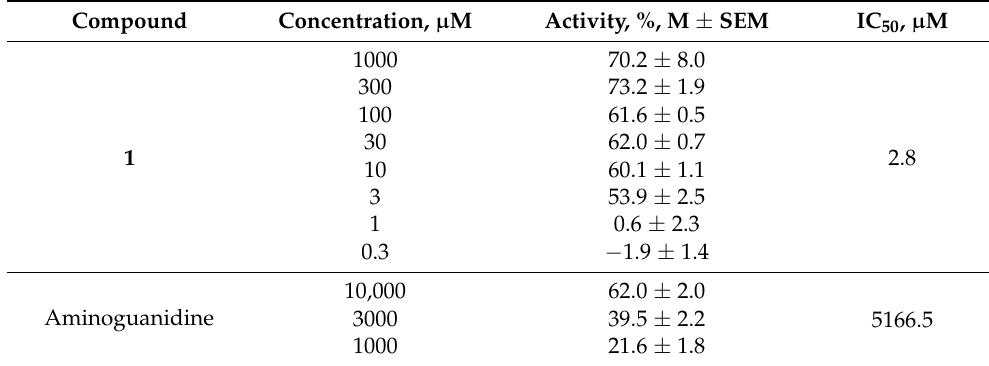
Table 2. Values established during the study of antiglycation